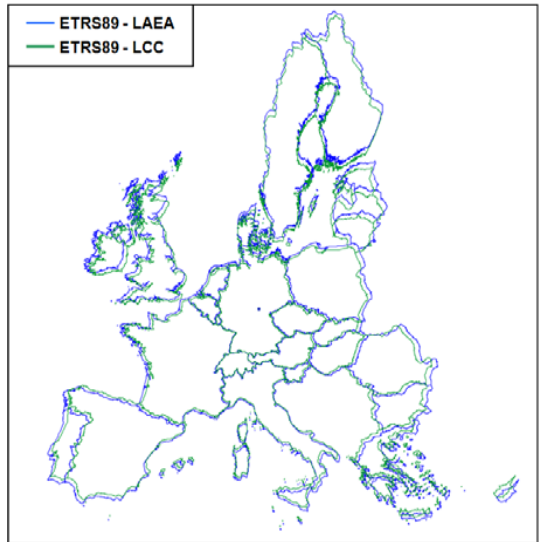
Figure 12: A representation of European Union countries using Lambert Azimuthal Equal-Area (in blue) and Lambert